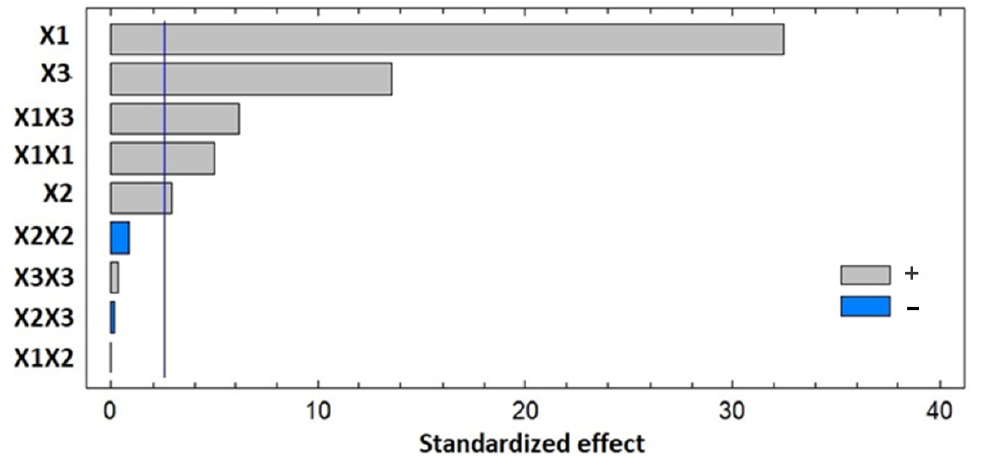
Figure 1. Preto chart for particle size of ICA-BM formulations, where X1, X2, and X3 represent the concentration of cholesterol:Span 20 ratio, bile salt, and MEL.